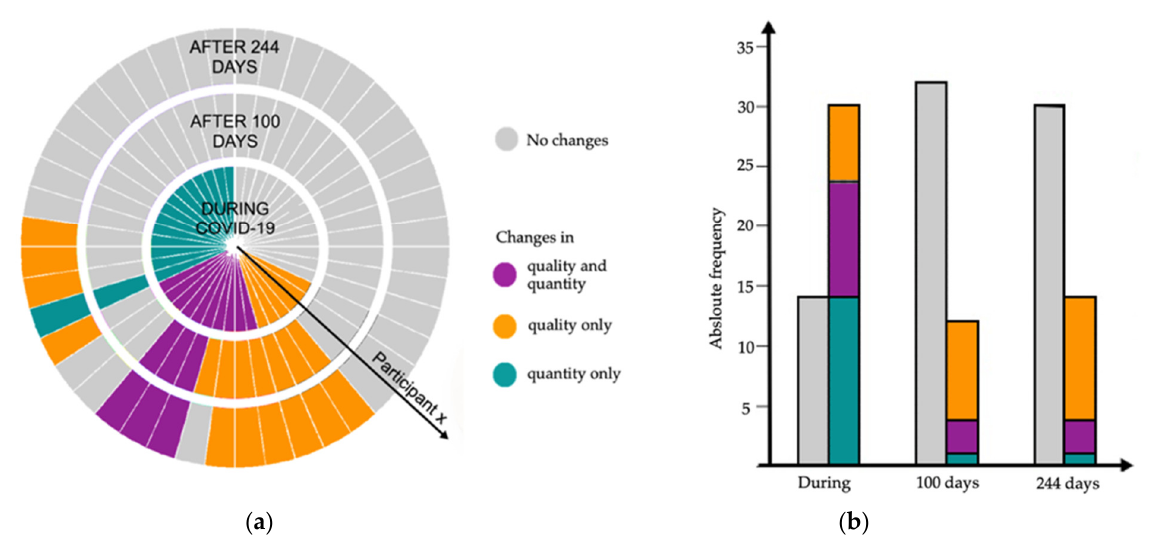
Figure 2. Quantitative and qualitative alterations in taste and smell of all 44 participants over the course of the study. Data on chemosensory dysfunction during the disease were collected in retrospectively, whereas information concerning 100 and 244 days were collected prospectively. ( a ) Development of quantitative and qualitative alterations of taste and smell of each participant. Each slice symbolizes one participant and the respective alteration of taste and smell during COVID-19 infection, as well as 100 and 244 days later. ( b ) Absolute frequencies and distribution of alterations in taste and smell over the course of study.